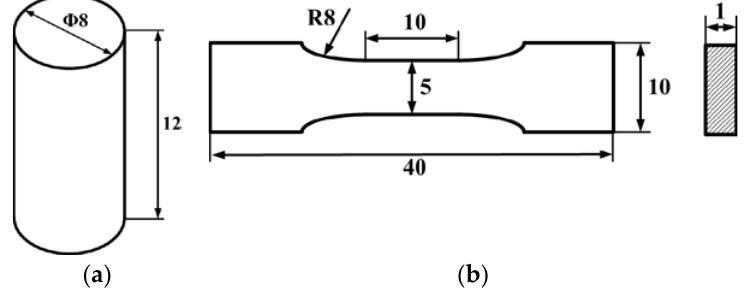
Figure 3. Dimension of the samples for experiment: ( a ) samples for compression test; ( b ) samples for tensile test.